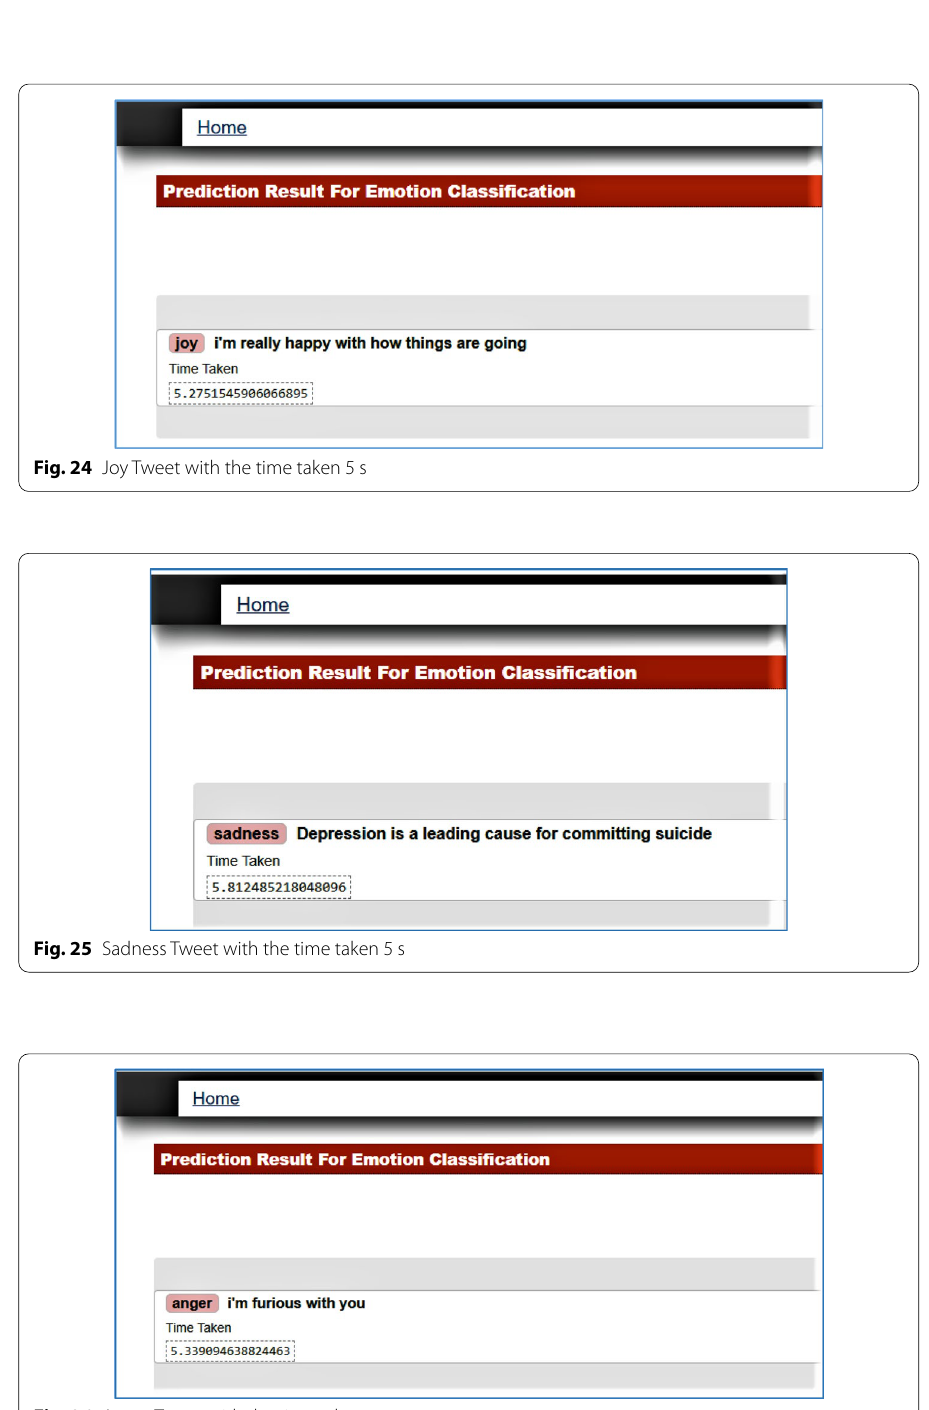
Fig. 26 Anger Tweet with the time taken 5